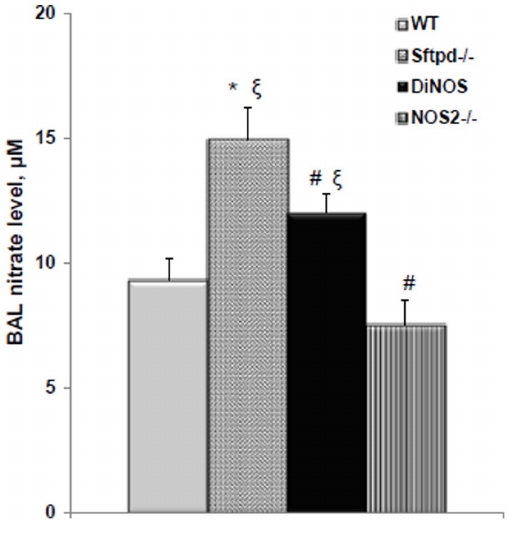
Figure 1. Ablation of NOS2 reduces NO metabolite production in DiNOS mice. BAL nitrates were measured by NOA as a marker of NOS activity. Values are mean 6 S.E. (n=6 to 15). Statistically significant differences between groups (p , 0.05) are indicated as: * vs WT; j vs NOS2 2 / 2 ; # vs Sftpd 2 / 2 mice.